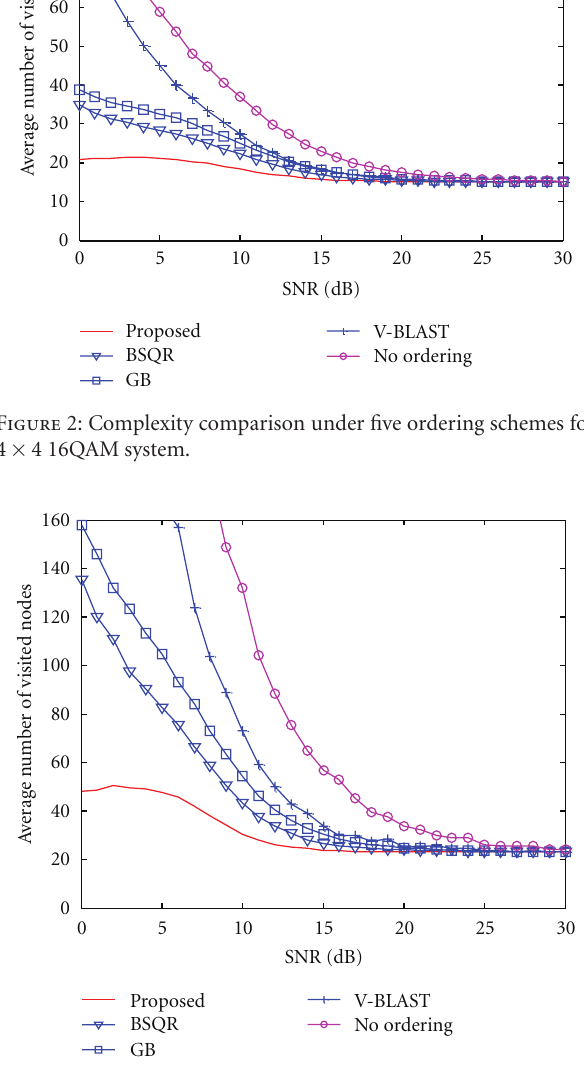
Figure 3: Complexity comparison under five ordering schemes for 6 × 6 16QAM